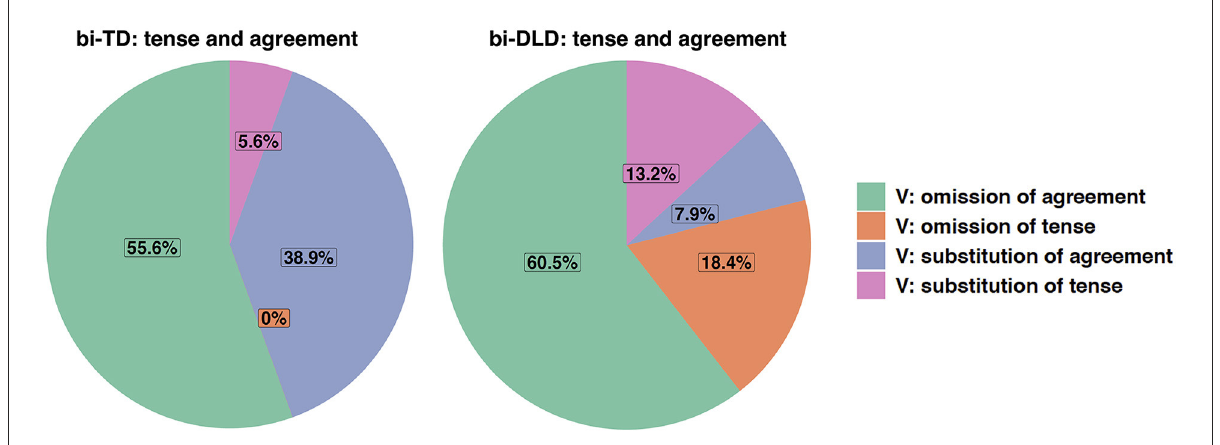
FIGURE3 Distributions of tense and agreement errors in Turkish in the bi-TD and bi-DLD group.